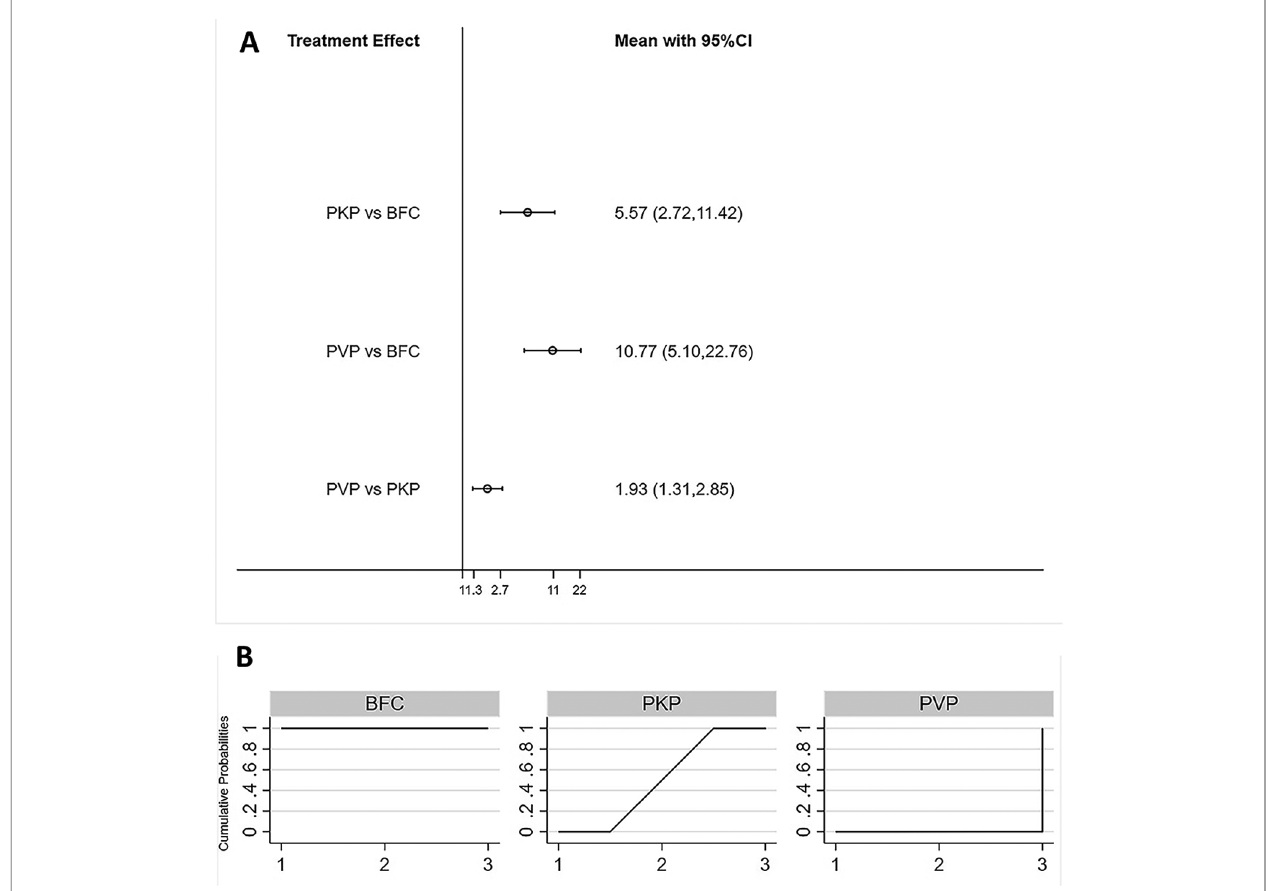
FIGURE 5 | Forest plot of cement leakage ( A ) and relevant SUCRA of each procedure ( B ). PVP, percutaneous vertebroplasty; PKP, Percutaneous kyphoplasty; BFC, bone- fi lling mesh